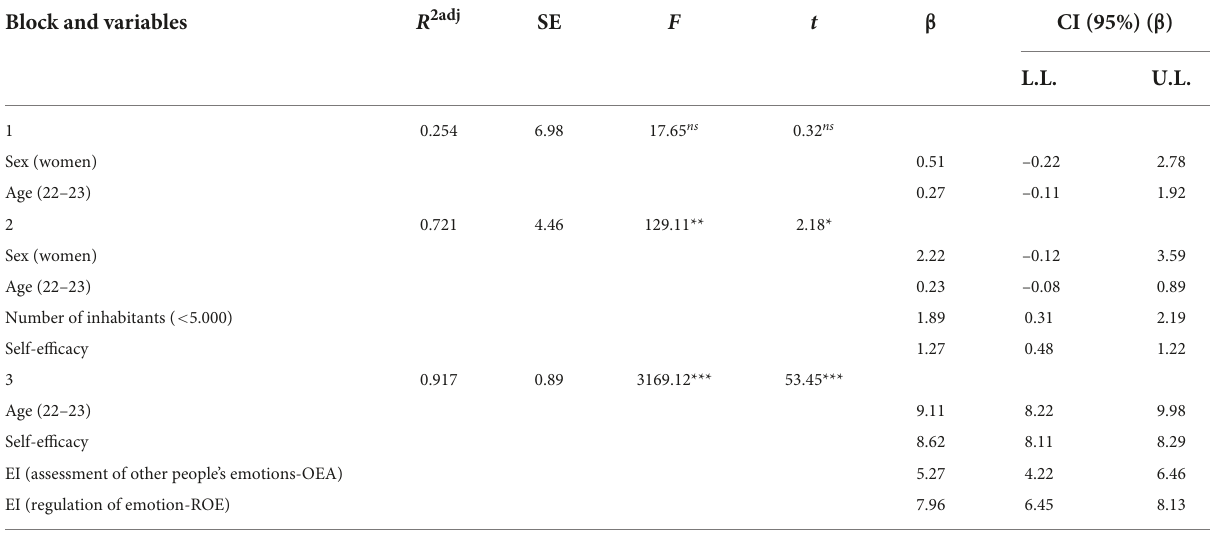
TABLE 8 Hierarchical prediction models of sociodemographic and psychological variables in Study 2 (EG = 134). Block and